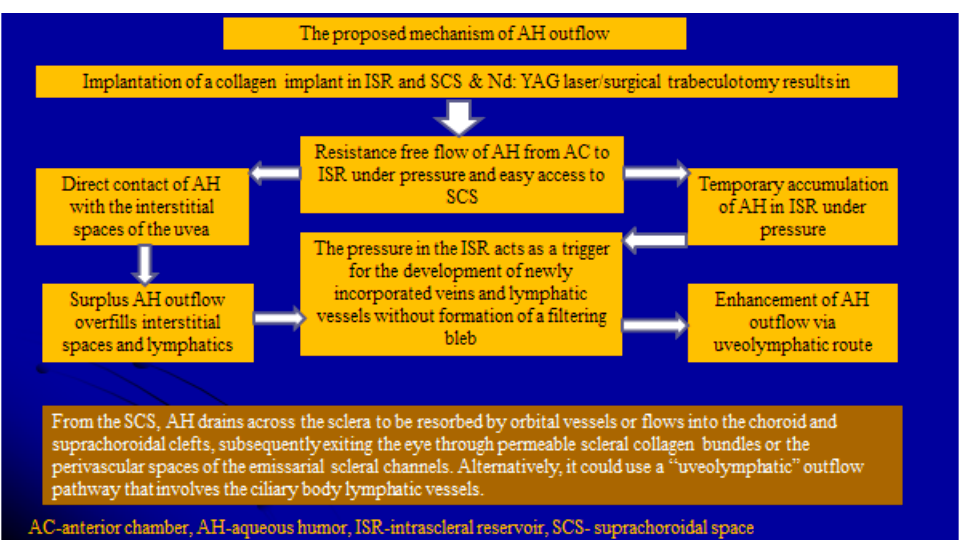
Figure 10. The proposed mechanism of aqueous humor outflow after the proposed glaucoma sur- gery.